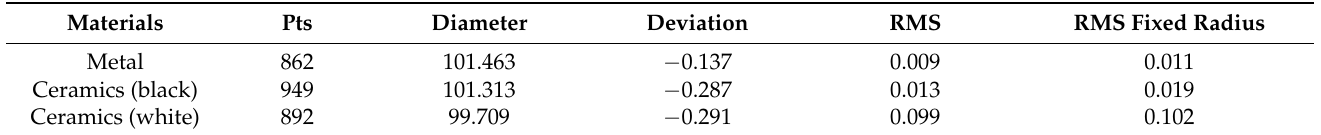
Figure 8. The re-construction based on the point clouds by the scanning measurements. Table 2. Comparison of LiDAR scanning results for a 101.6 mm ball.